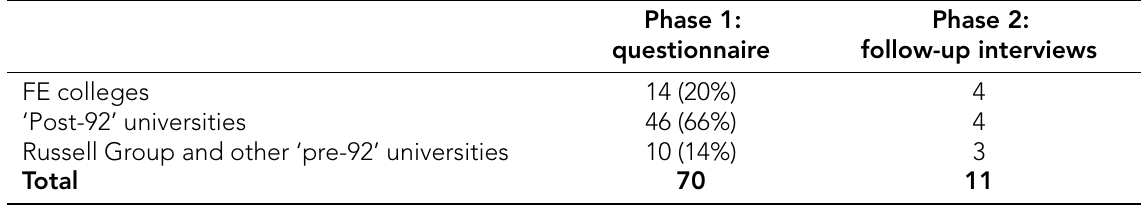
Table 1. An overview of programme leaders participating in the research (Source: Authors,